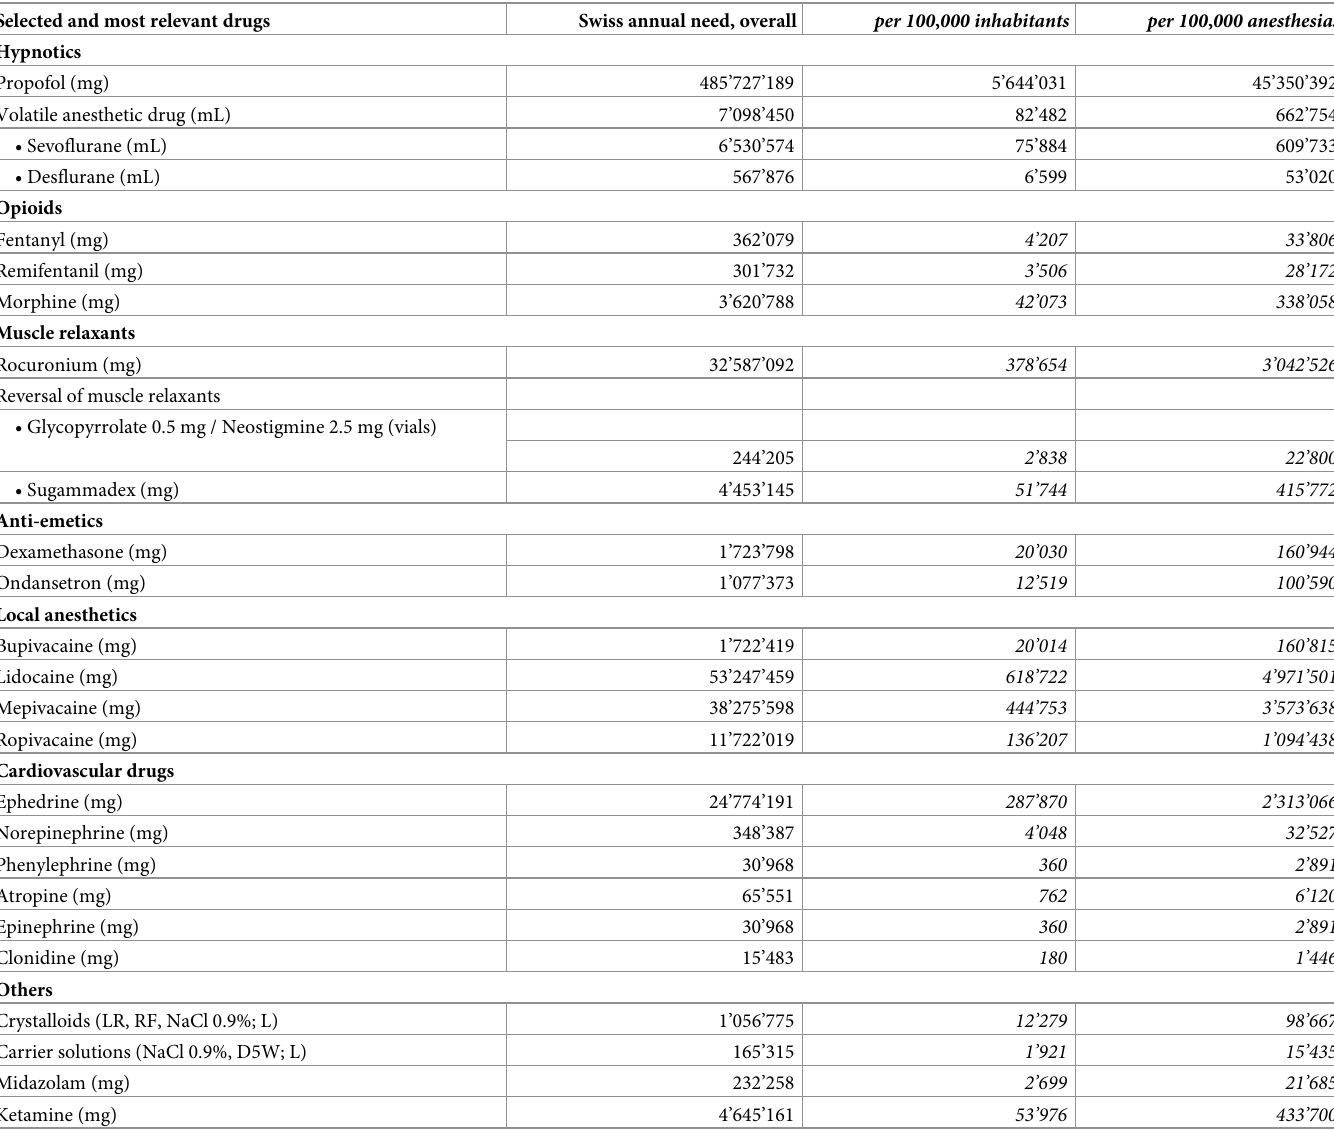
Table 2. Estimated annual need of selected drugs for Swiss anesthesia